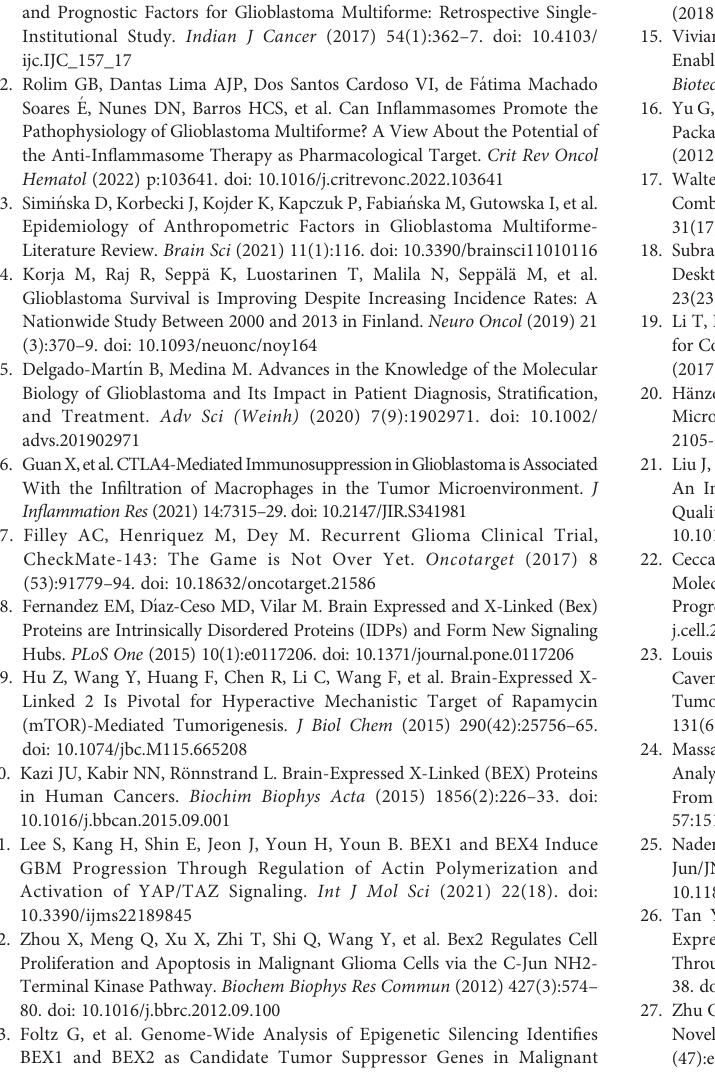
Supplementary Figure 2 | Immune in fi ltration analysis of BEX family in GBM. Immune cells. aDC [activated DC]; B cells; CD8 T cells; Cytotoxic cells; DC; Supplementary Figure 3 | GO term analysis and KEGG pathway enrichment analysis of BEX family in GBM. Supplementary Figure 4 | PPI network of BEX family and TCEAL family: there was a signi fi cant correlation between the expression levels of BEX family genes and TCEAL family genes in GBM.